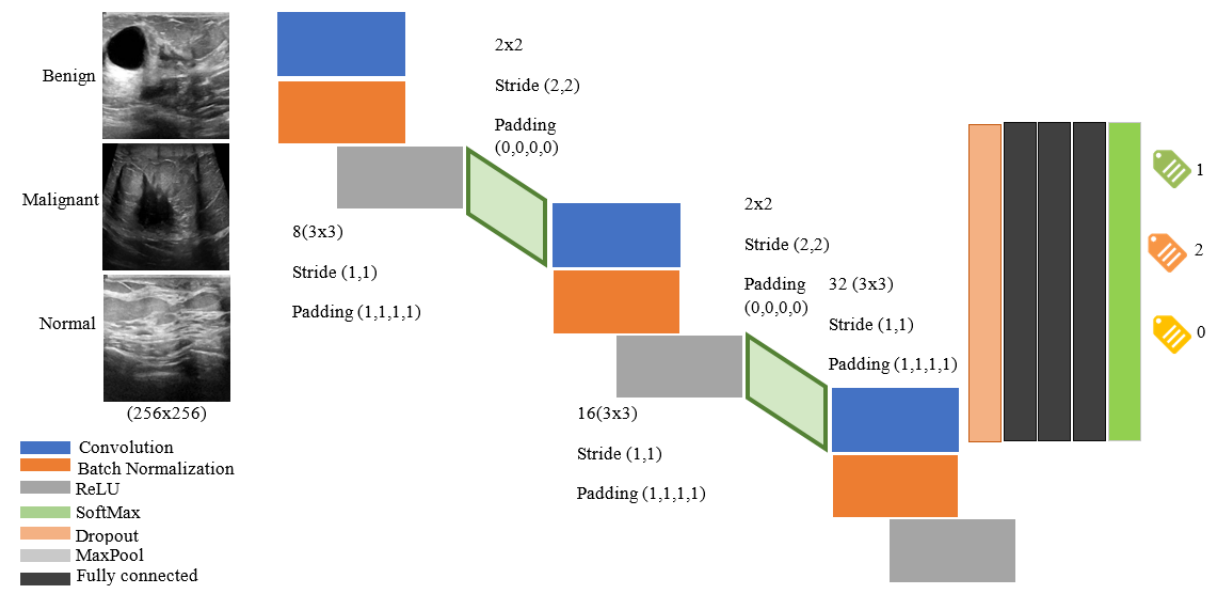
Figure 4. The architecture provided by CNN for classifying or diagnosing tumor type and disease.